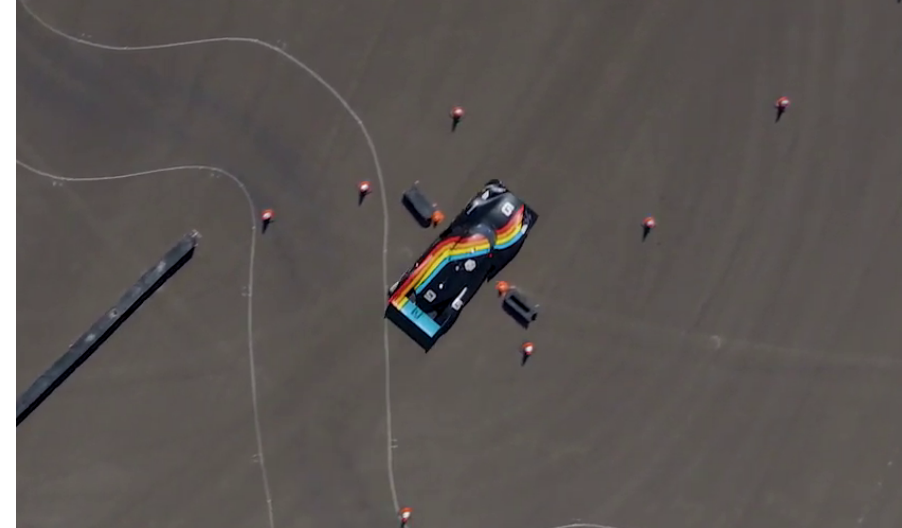
Figure 11. Top view of the Roborace DevBot 2.0 in Zala Zone Circuit. Narrow corridors (gates) were distributed along the track, the car is 2 meters wide, while the gates were 2.5 meters